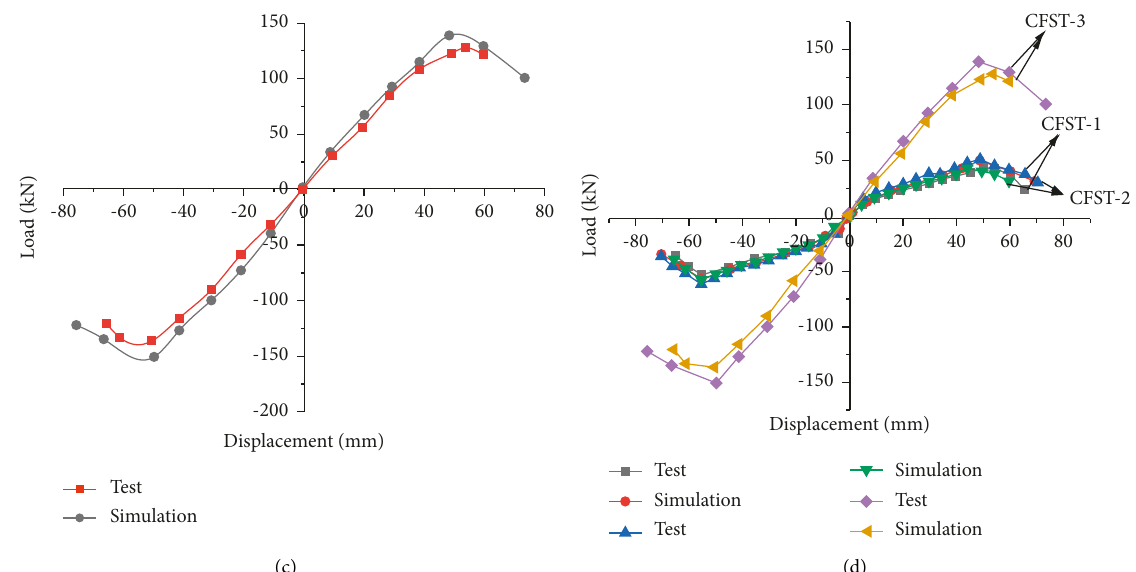
Figure 13: Comparison of skeleton curves. (a) CFST-1, (b) CFST-2, (c) CFST-3, and (d) comparison of skeleton curves under different parameters.